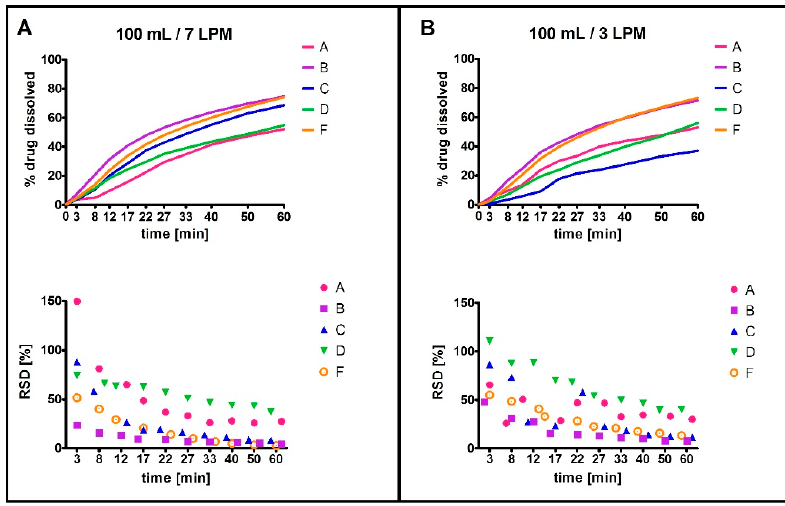
Figure 5. Dissolution data from Phase 2 (100 mL), tested at 7 LPM ( A ) and 3 LPM ( B ) agitation rate. The bottom graphs show the individual RSD values for each time point.